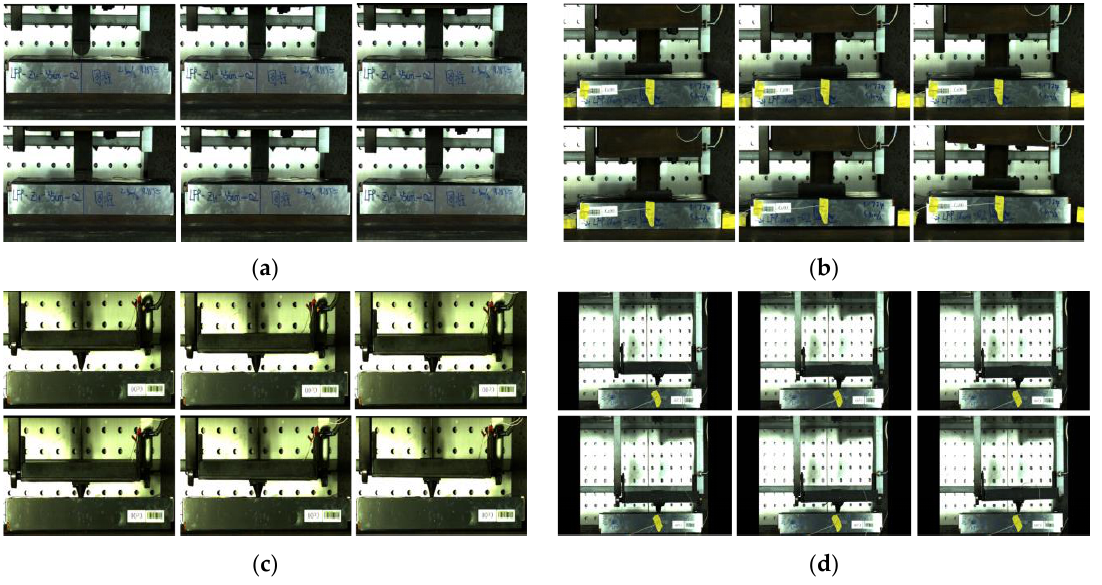
Figure 14. Z direction extrusion deformation process of the battery module. ( a ) The Z1+ orientation test results of the module; ( b ) The Z2+ orientation test results of the module; ( c ) The Z3− position test results of the module; ( d ) The Z4− position test results of the module.